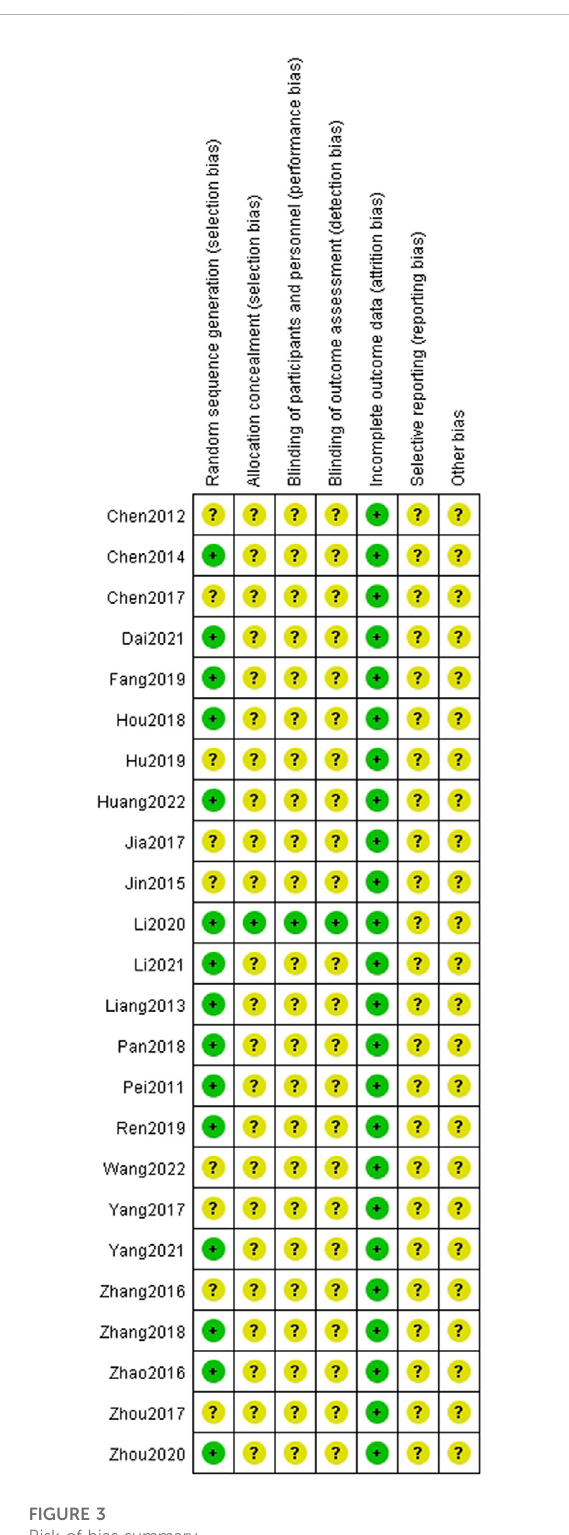
FIGURE 3 Risk of bias